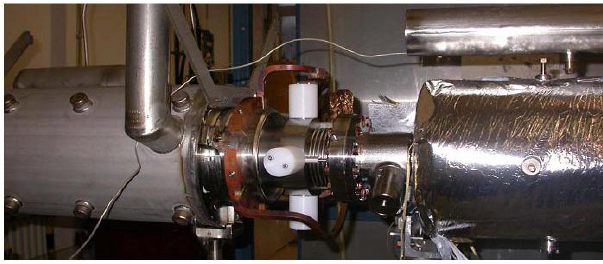
FIG. 3. (Color) BPM installed in a cryomodule with four feed- throughs protected by plastic cylinders during mounting.